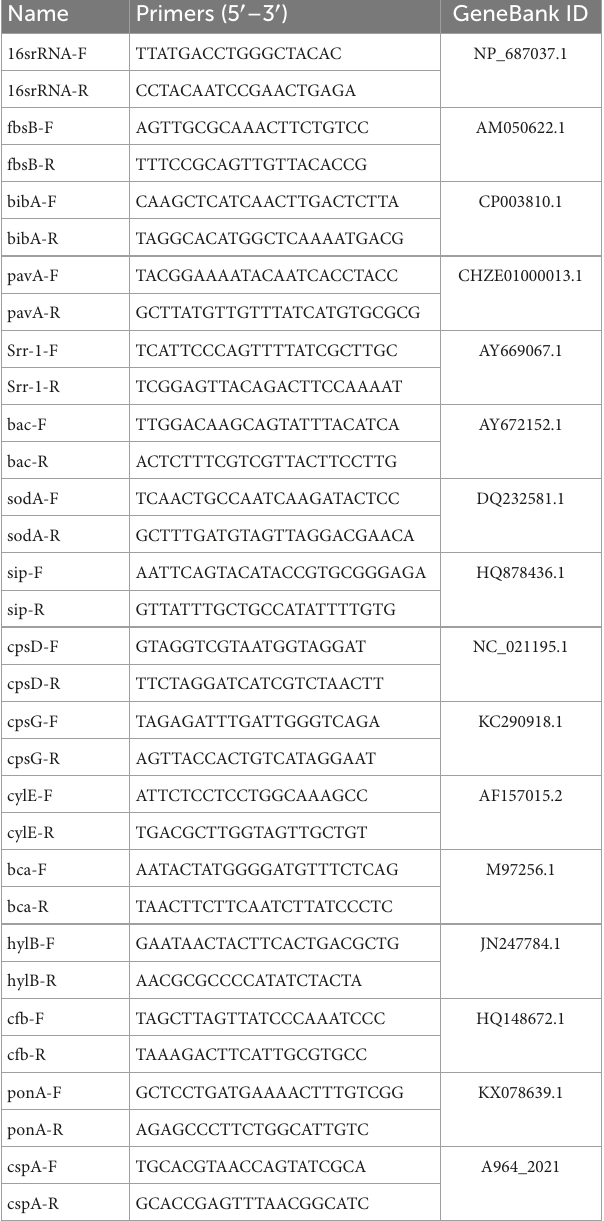
TABLE 3 Primers for S. agalactiae virulence